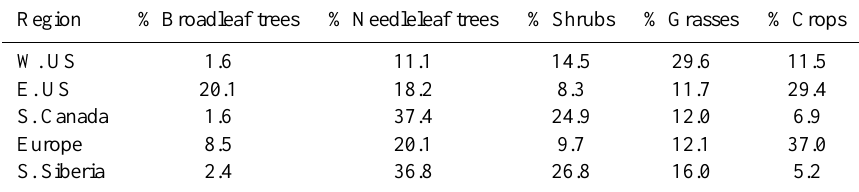
Table 2. Percent coverage of plant functional types in the MEGAN landcover database for selected midlatitude regions 1 . Region % Broadleaf trees % Needleleaf trees % Shrubs % Grasses